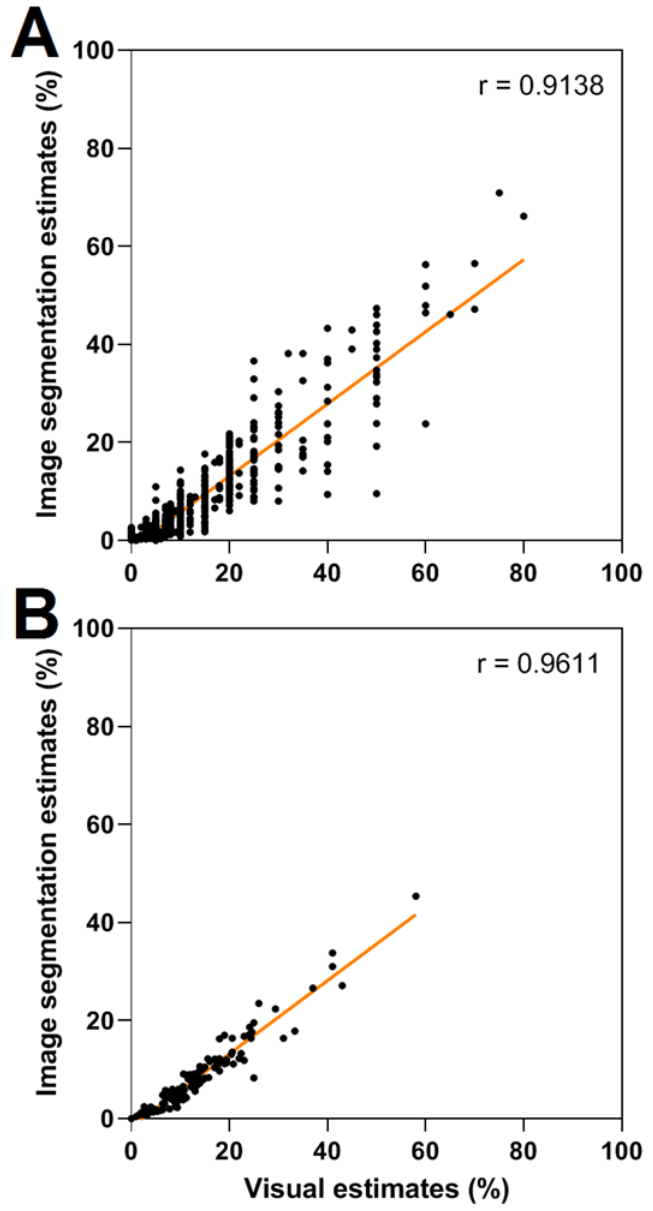
Figure 3. Pearson correlation between visual-based infection estimates and image segmentation-based infection estimates for individual samples (A) and genotypes averages